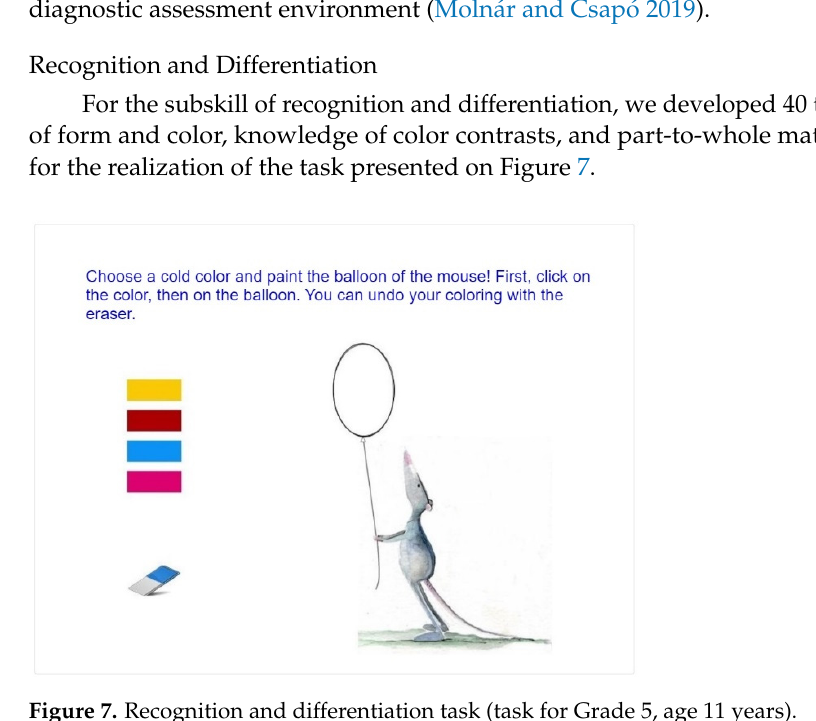
Figure 8. Task for interpreting symbols and recognition of visual connections for Grade 6, age 12 years. Visual Analysis: Reading Messages Conveyed in Abstract Compositions As part of visual communication, abstraction is the creation of signs and shapes by highlighting, simplifying, and reducing (Figure 9) Abstract compositions may convey meaningful signs and symbols. Carefully composed visual effects may evoke the same emotions or thoughts in different viewers. Our interpretation of visual elements is based on conventions transmitted through real-life experiences and organized through educational interventions. To communicate effectively through signs and symbols, the rules of visual perception should be acquired. In designing the test items, we used the tasks and illustrations of Paul Klee’s Pedagogical Sketchbook (Klee [1953] 1973). Paul Klee